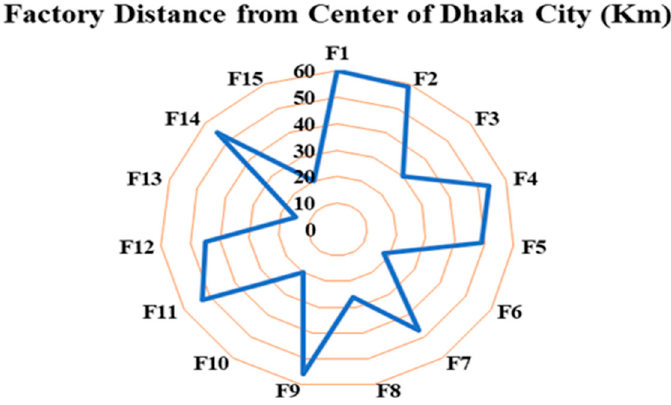
Figure 3. List of factory distances from the center of Dhaka city.